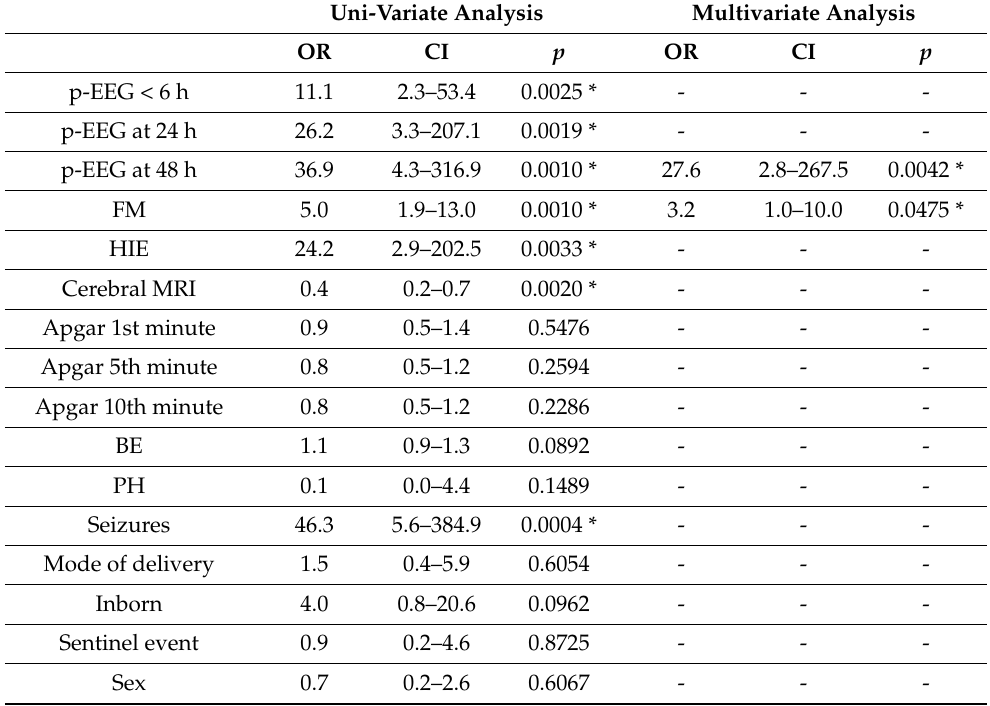
Table 4. Uni- and multivariate analysis in cooled infants. Uni-Variate Analysis Multivariate Analysis